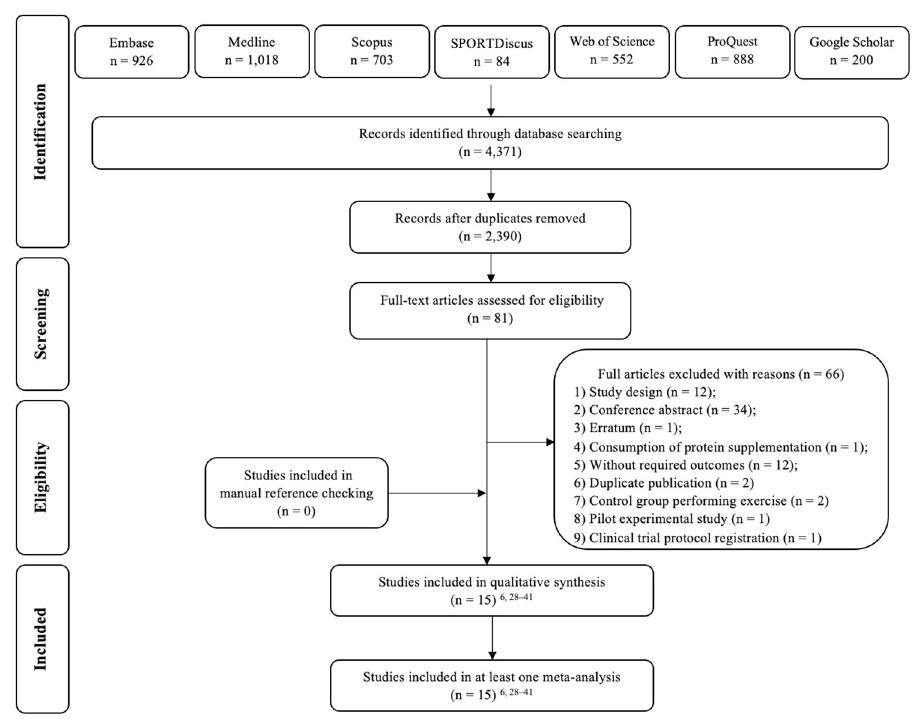
Fig 1. Flowchart of the selection